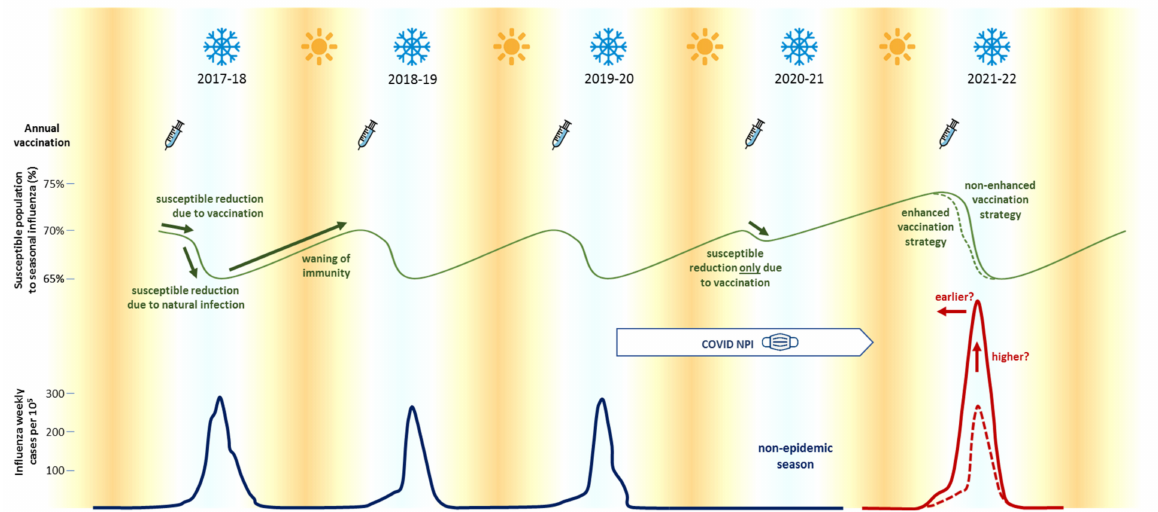
Figure 1. Seasonal influenza epidemics occurred yearly during the winter at the tempered weather latitudes (blue line). Susceptible population (solid green line) declines in autumn due to vaccination campaigns, and later, in winter, due to natural infection. Non-pharmacological interventions (NPIs) to prevent COVID-19 have reduced the incidence of influenza epidemics during the 2020–2021 season. Theoretically, once NPI measures are relaxed, the next influenza epidemic could occur sooner and reach higher incidence (solid red line) due to the higher percentage of susceptible population. In order to ensure that the next influenza epidemic occurs within the usual limits (dotted red line), it would be necessary to enhance the vaccination strategy for reducing the susceptible population at least to the levels otherwise reached through natural infection (dotted green line), or to adopt measures to reduce the intensity of infection, such as children vaccination